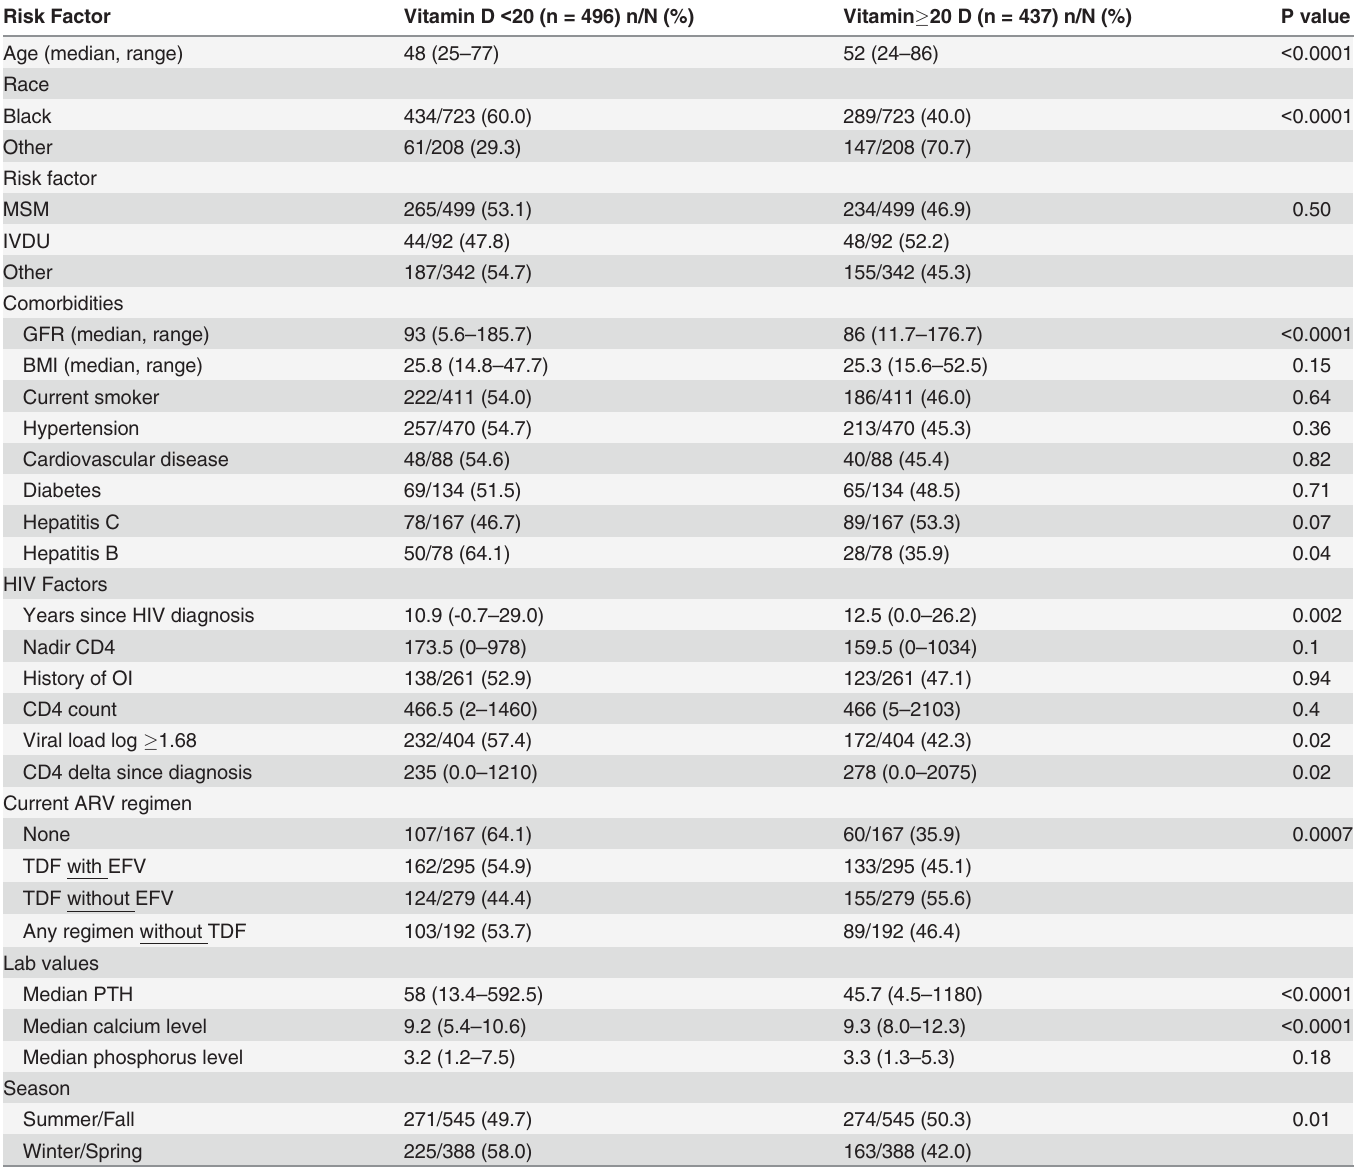
Table 4. Risk factors associated with Vitamin D deficiency, HIV-positive patients; univariate